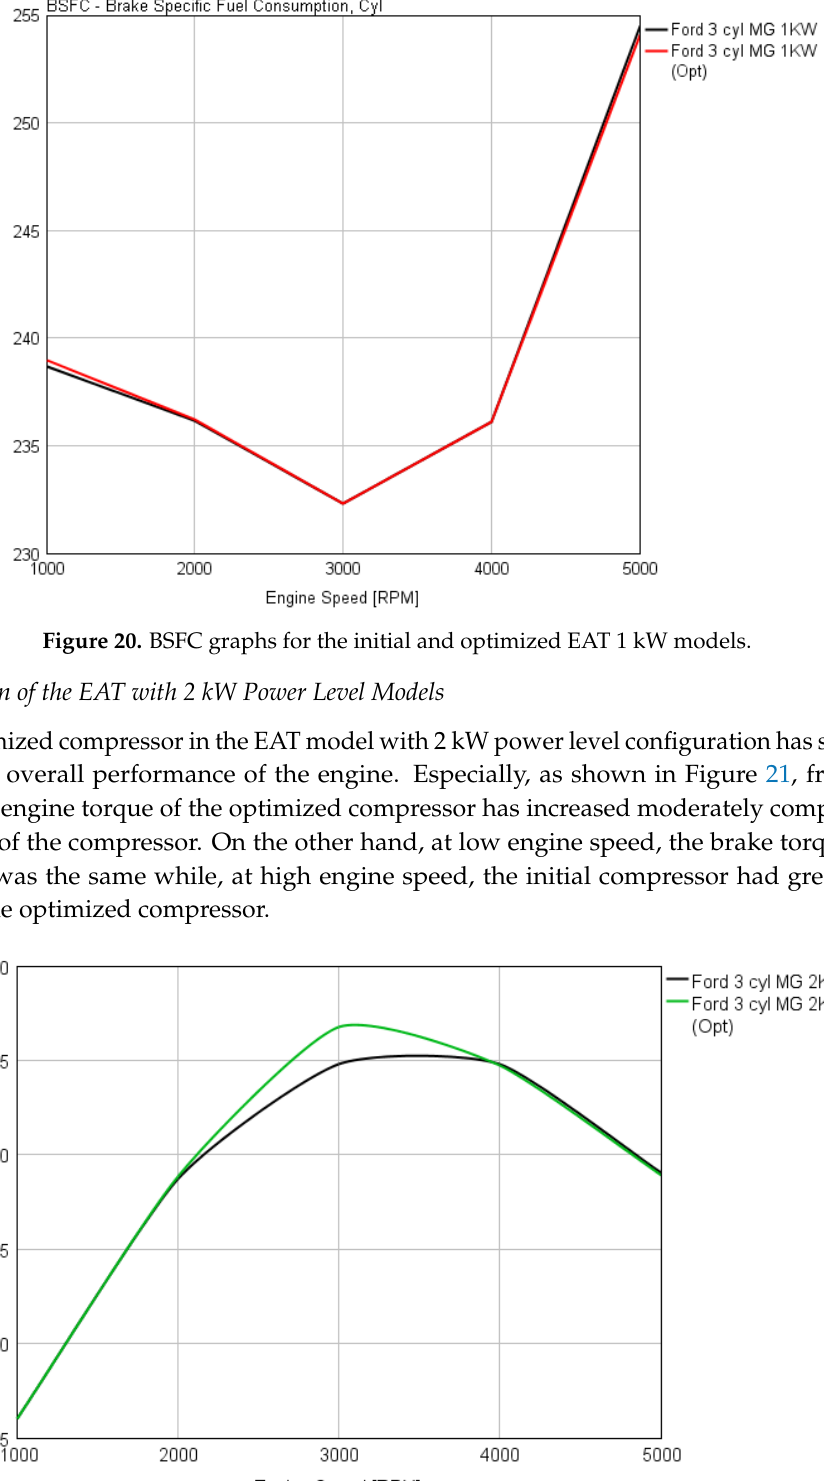
Figure 19. Brake torque over engine speed for the initial and the optimized EAT 1 kW models.